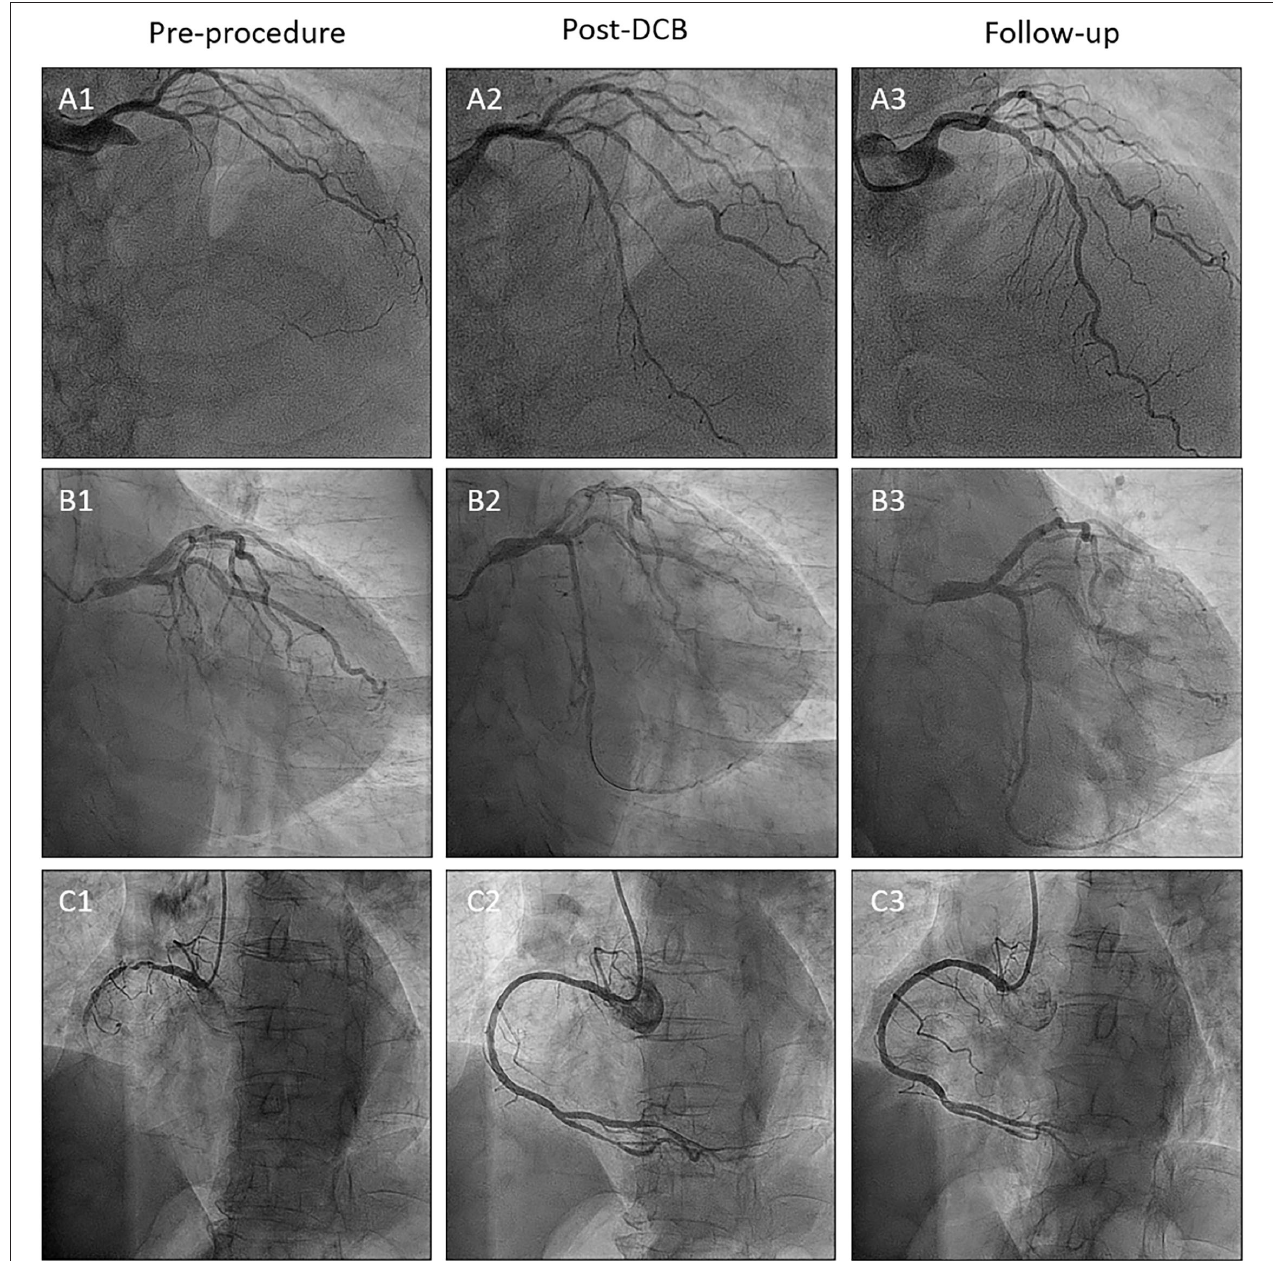
FIGURE 2 | Representative CTO cases. (A) Left anterior descending artery lesion. (B) Left circumflex artery lesion. (C) Right coronary artery lesion. Number 1; Preprocedure. Number 2; Post-DCB treatment. Number 3; Follow-up. CTO, chronic total occlusion.